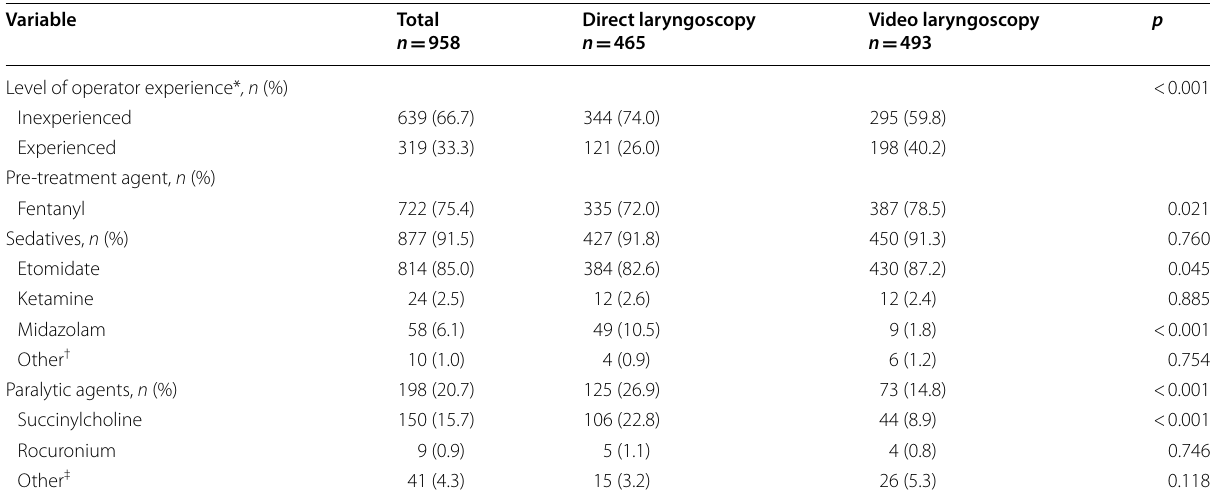
Table 2 Characteristics of the physicians and types of hypnotic medication and neuromuscular blocker